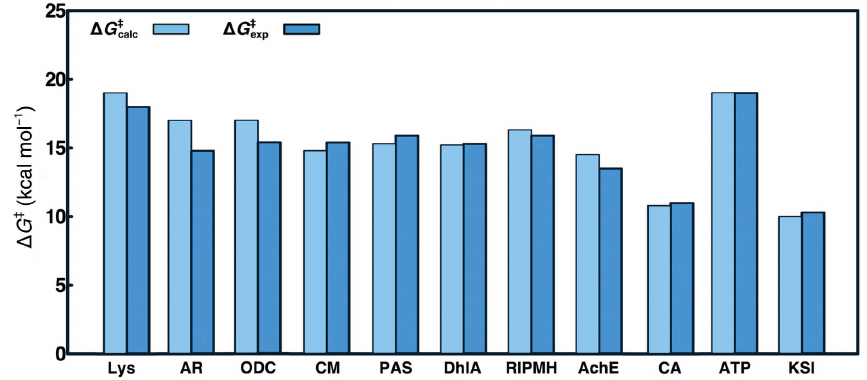
Figure 3 A comparison of calculated (using EVB, (cid:2) G ‡ calc ) and experimentally observed ( (cid:2) G ‡ exp ) activation free energies for the reactions catalyzed by dihydrofolate reductase (DHFR), lysozyme (Lys), aldose reductase (AR), chorismate mutase (CM), trypsin (Try), a bacterial arylsulfatase (PAS), haloalkane dehalogenase (DhlA), triosephosphate isomerase (TIM), a bacterial phosphonate monoester hydrolase (RlPMH), acetylcholine esterase (AchE), orotidine monophosphate decarboxylase (ODC), carbonic anhydrase (CA), F 1 -ATPase (ATP) and ketosteroid isomerase (KSI). This figure was prepared based on data presented in Warshel et al. (2006), Kamerlin et al. (2010), Luo et al. (2012) and Barrozo et al. (2015), and references cited